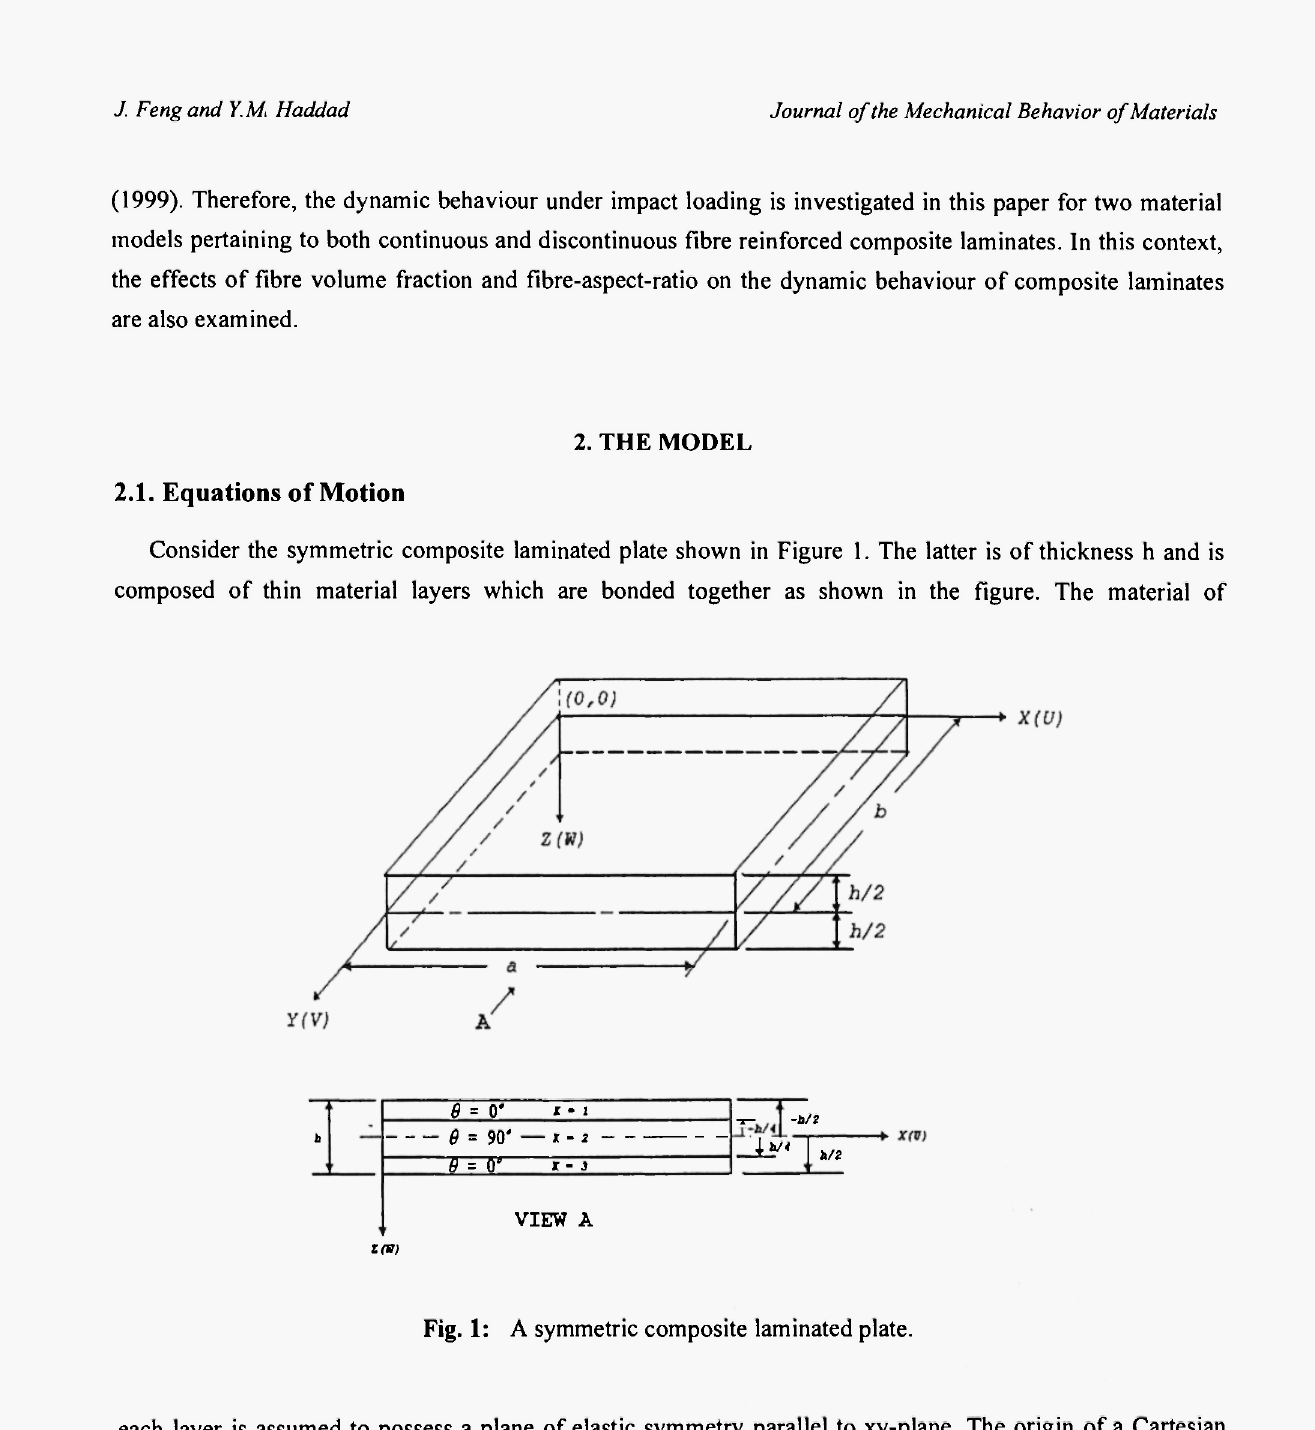
Fig. 1 : A symmetric composite laminated